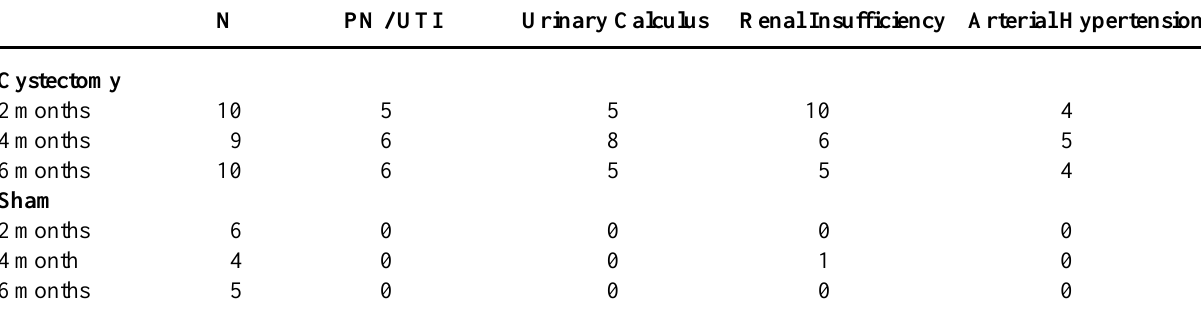
Table 1 – Complications in rats submitted to supratrigonal cystectomy and sham surgery.